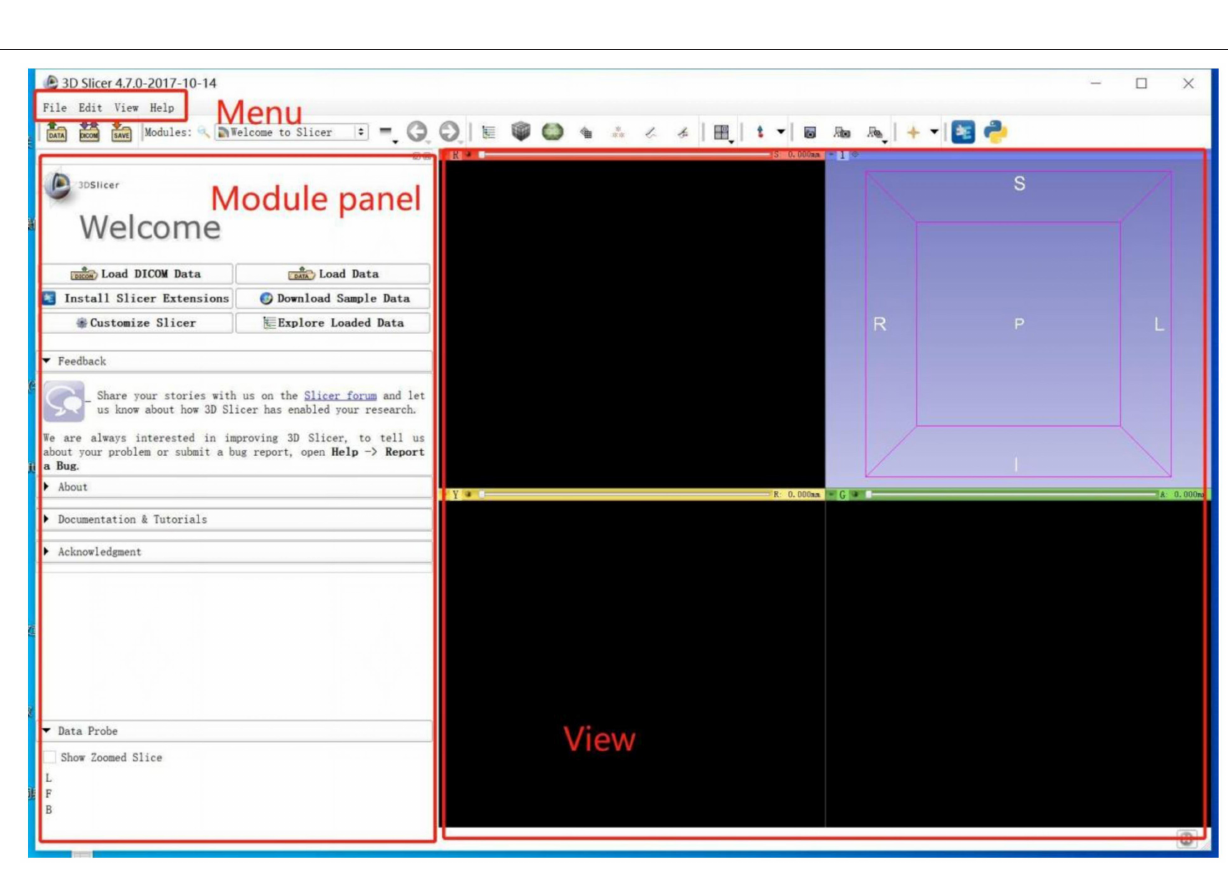
FIGURE 2 | The interface of 3D-Slicer software (version